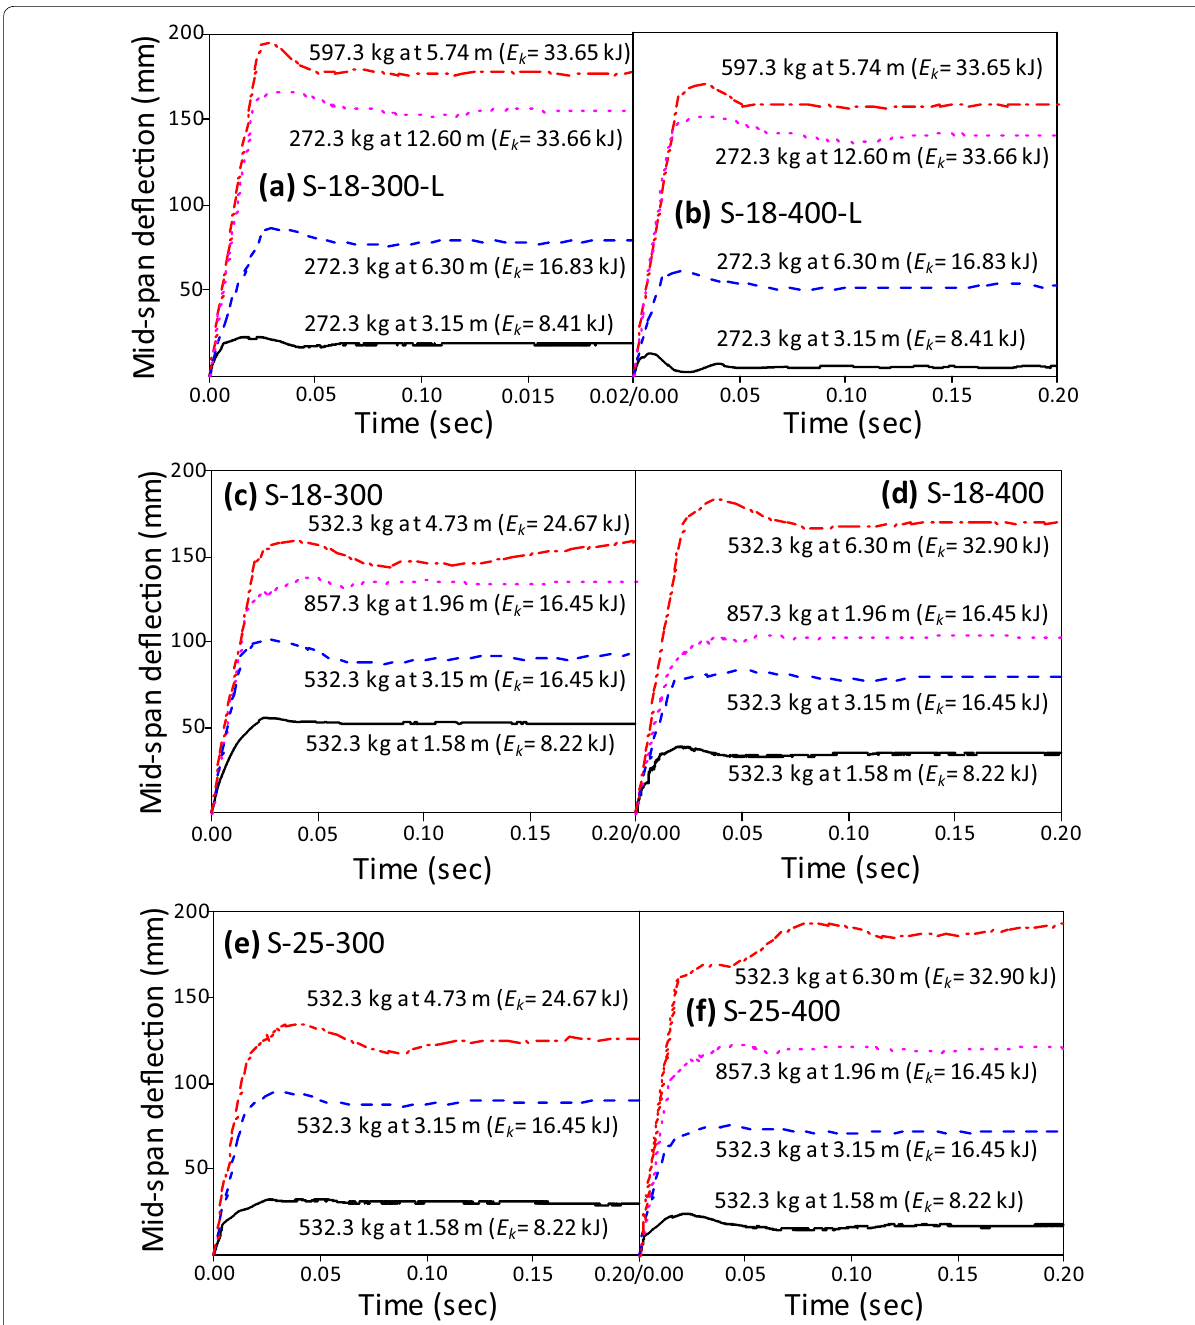
Fig. 4 Mid‑span deflection